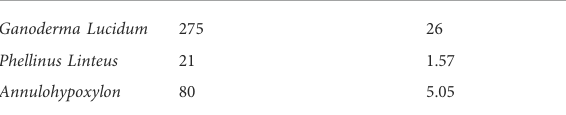
TABLE 3 Measured mechanical properties of mycelium biocomposites.ThevaluesareobtainedfromthecurveinFigure3. G. lucidum has the highest modulus (~200 MPa) and highest strength (~20 MPa), however, the results depend a lot on the size of the